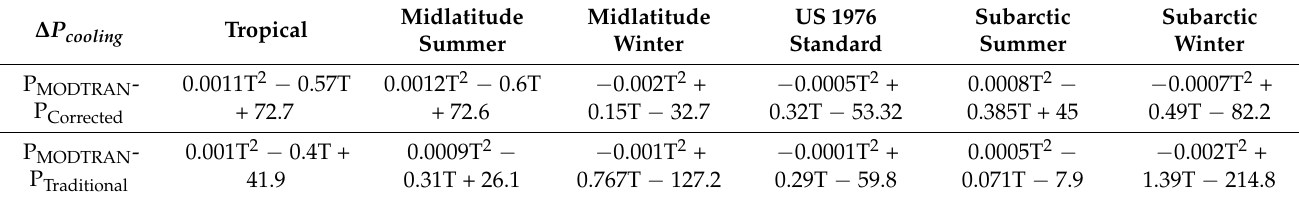
Midlatitude Winter